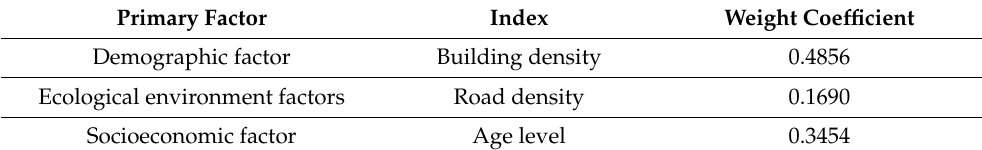
Table 6. Disaster-bearing body vulnerability assessment index system and weight coefficient.